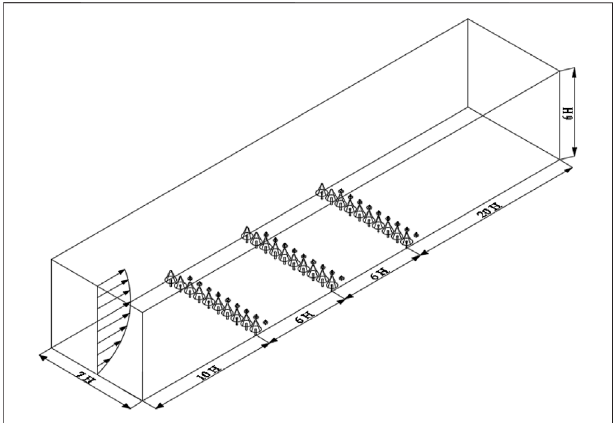
FIGURE 2 | Schematic diagram of the 3D fi nite element model of the